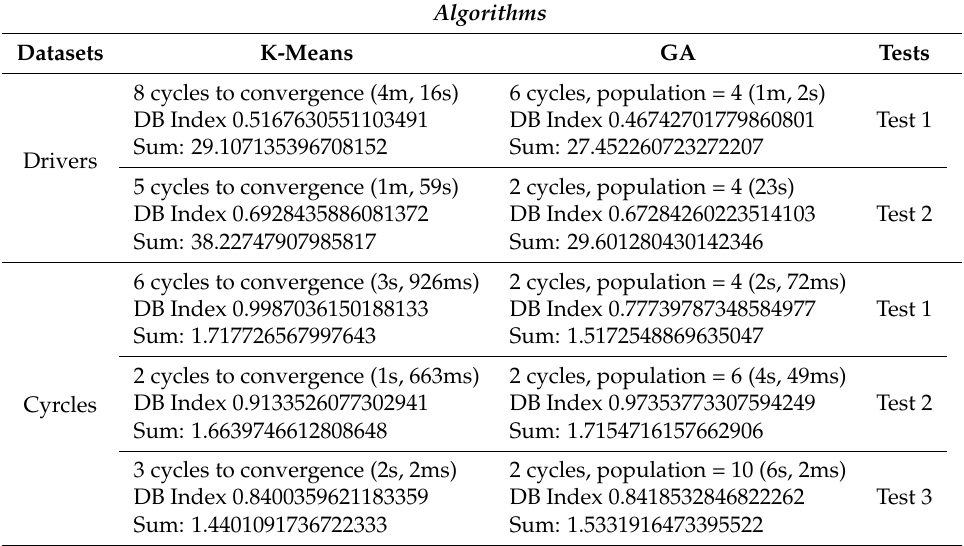
Table 4. The results of performed tests for both algorithms.